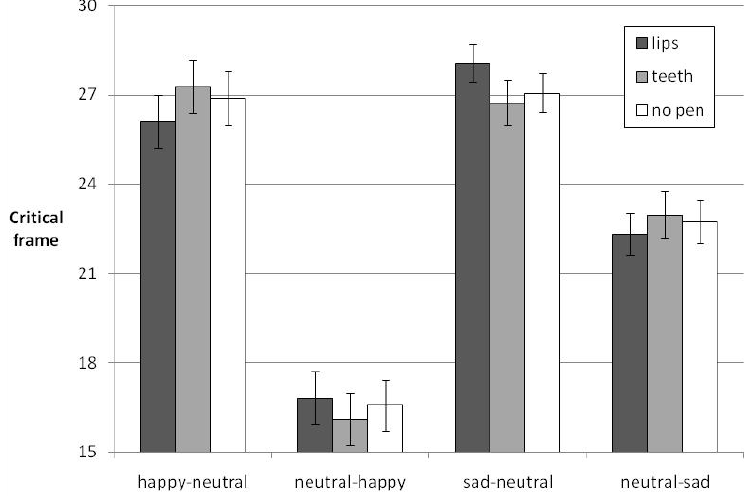
Figure 1. Means of critical frames averaged across participants, separately for the four morph sequences and three pen conditions, for expressions changing between happy/sad and neutral. Error bars depict